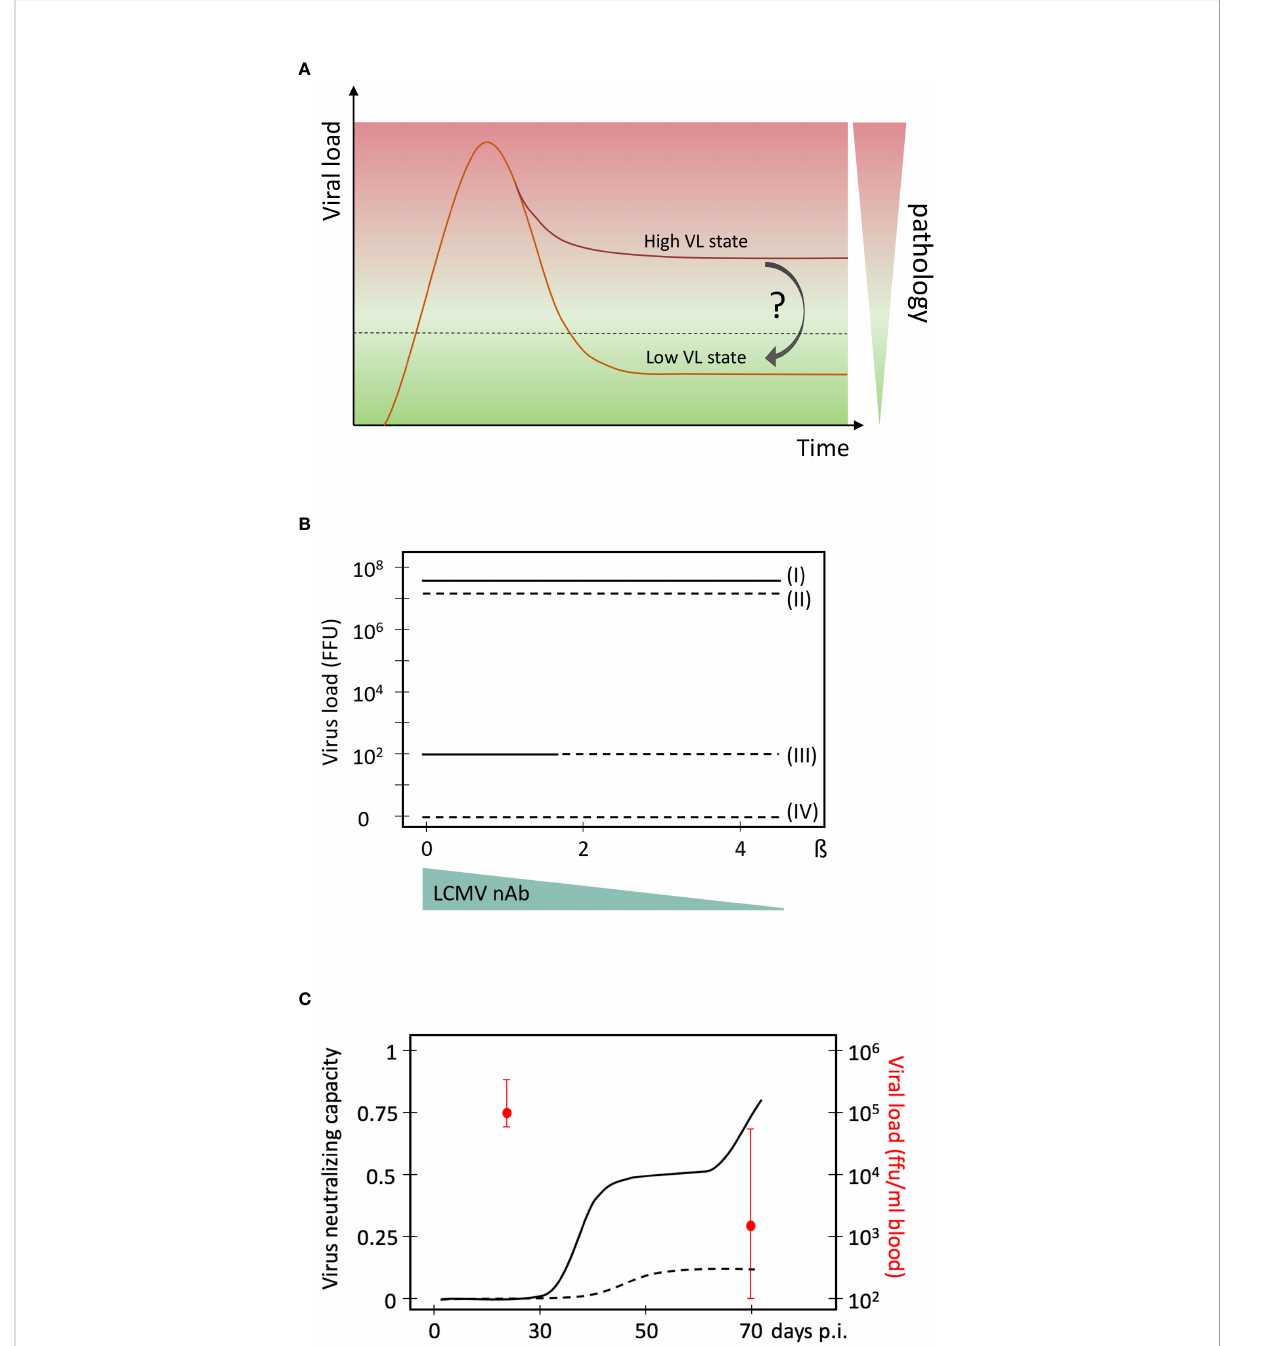
FIGURE 1 High and low virus load (VL) equilibrium states in persistent chronic virus infections. (A) Schematic presentation of a high and low virus load state, and the associated pathology. (B) Mathematical model predictions of multiple virus equilibrium states (I to IV) in LCMV infections of mice as a function of the net virus growth rate b . Data are from (28). The four virus equilibrium states differ in their values of the virus load from the highest (state I) to the lowest (state IV). Stability of an equilibrium state or steady state means that the system returns back after some perturbation. Only stable equilibrium states are biologically observable. State I is always stable while state III is stable for a certain range of b (solid lines). States II and IV are unstable (broken lines) and cannot be observed biologically. A possible reduction of b by neutralising antibodies is indicated below. It represents the natural occurrence of a late, speci fi c neutralizing antibody response during chronic LCMV infection that reduces the net virus growth rate represented by b . (C) Evolution of virus neutralising capacity of mouse sera during an experimental LCMV infection of mice. Experimental data are from (29) and converted into this presentation. Medians of viral loads at days 30 and 70 and their interquartile ranges are indicated in red. Solid line, sera from chronic infection; broken line, sera from acute